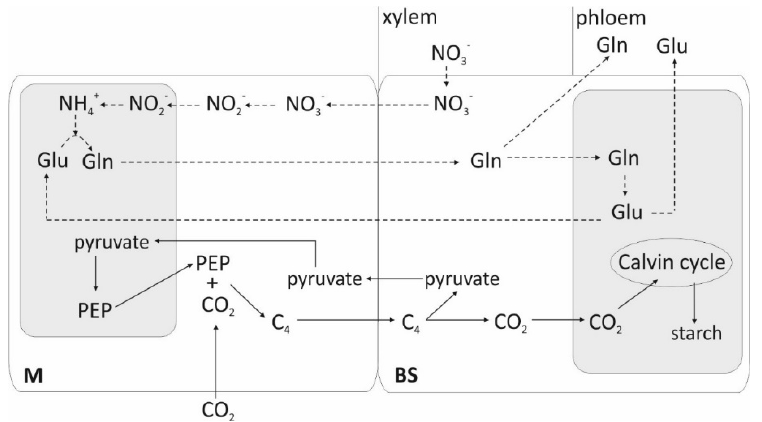
Figure 3. Schematic representation of the distribution of major steps in assimilation of carbon and nitrogen between mesophyll (M) and bundle sheath (BS) cells of maize. Dark-shaded rectangles represent chloroplasts; transport steps of C compounds are marked by solid arrows; dashed lines indicate the transport of N compounds. Gln: glutamine; Glu: glutamate. Modified by Kopriva and Kopriva [ 88 ].